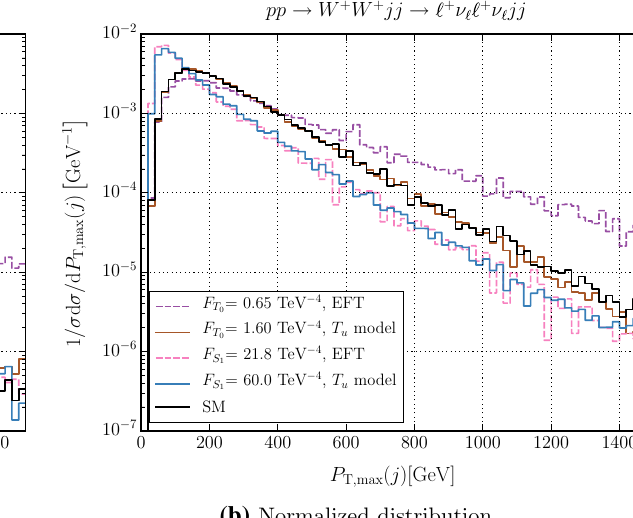
solid blue and brown lines show the corresponding T u model for O S and O T . Beyond the cuts in Eq. (34) we impose m (cid:6)(cid:6) > 500 GeV 0